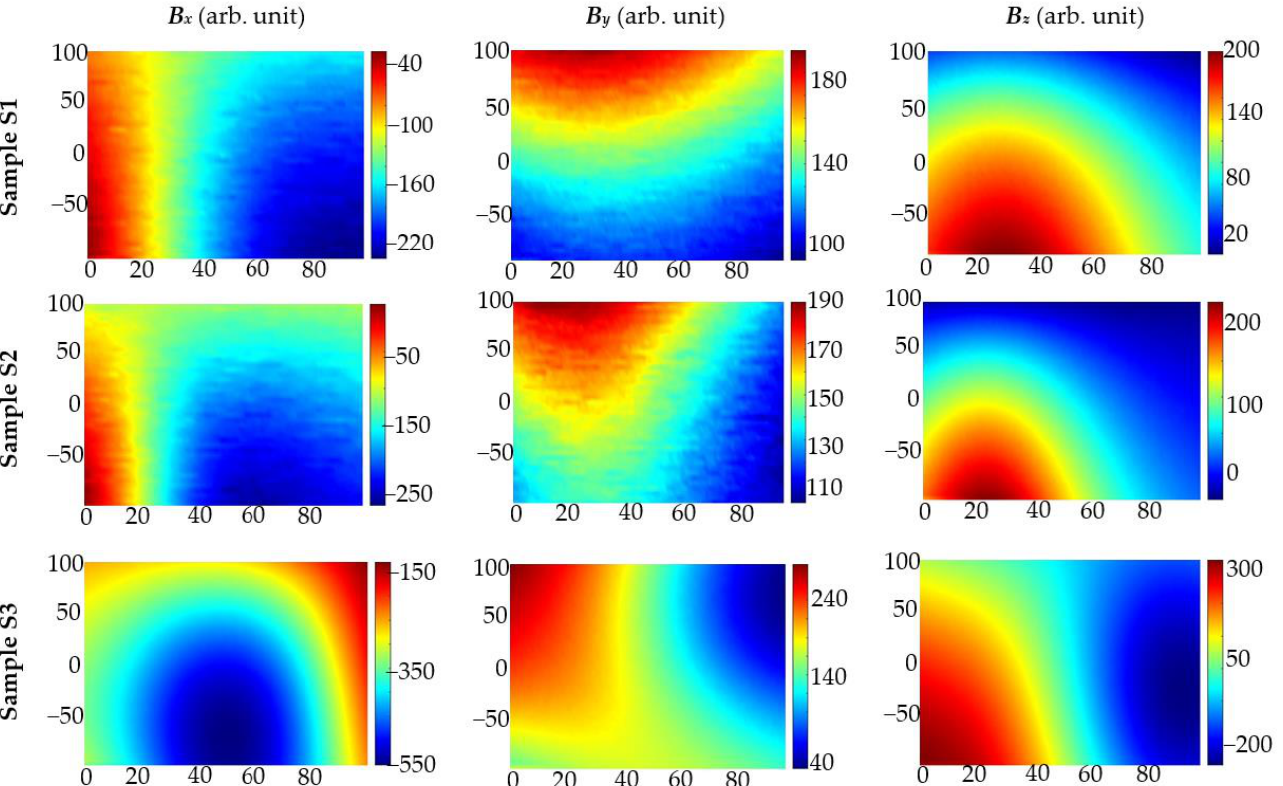
Figure 21. Results of 2D measurements using AMR sensor obtained for different samples (S1, S2, S3); without magnetization; thickness of the concrete cover h = 40 mm; x (mm), y (mm)—sensor positions.